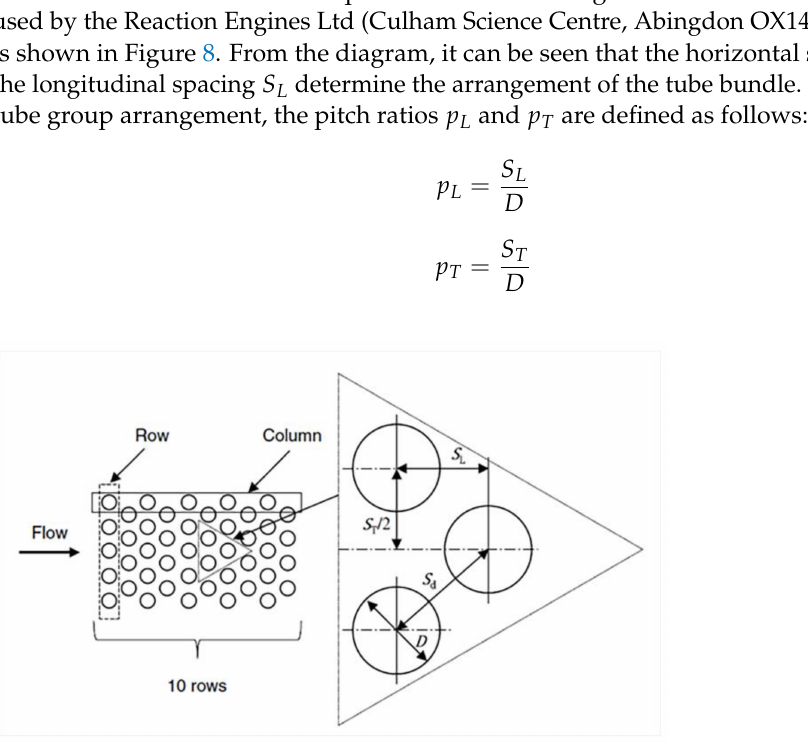
Figure 8. Tube bundle structure and tube spacing.